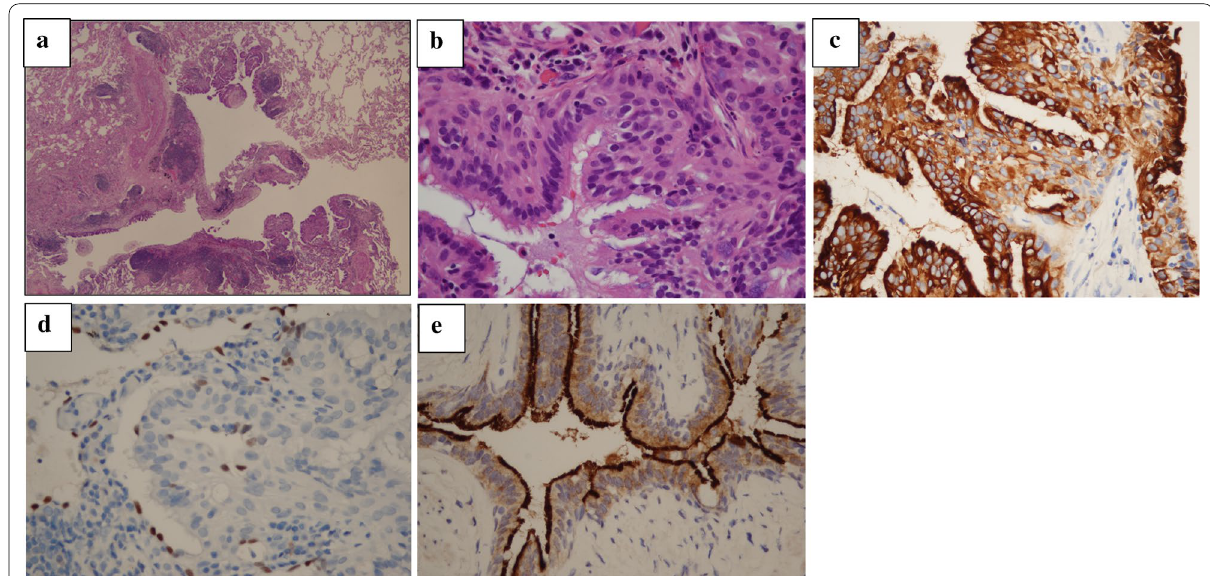
Fig. 3 a Cyst cavity showing proliferation of papillary cells with cilia adjacent to the bronchi and mucous glands around the cystic wall (HE, b Mucous gland suggests alveolar structures were intact and composed of normal epithelial cells with no atypical cells (HE, tumor. c CK7 staining was strong and diffuse in most epithelial cells ( were positive for BRAF staining ( ×